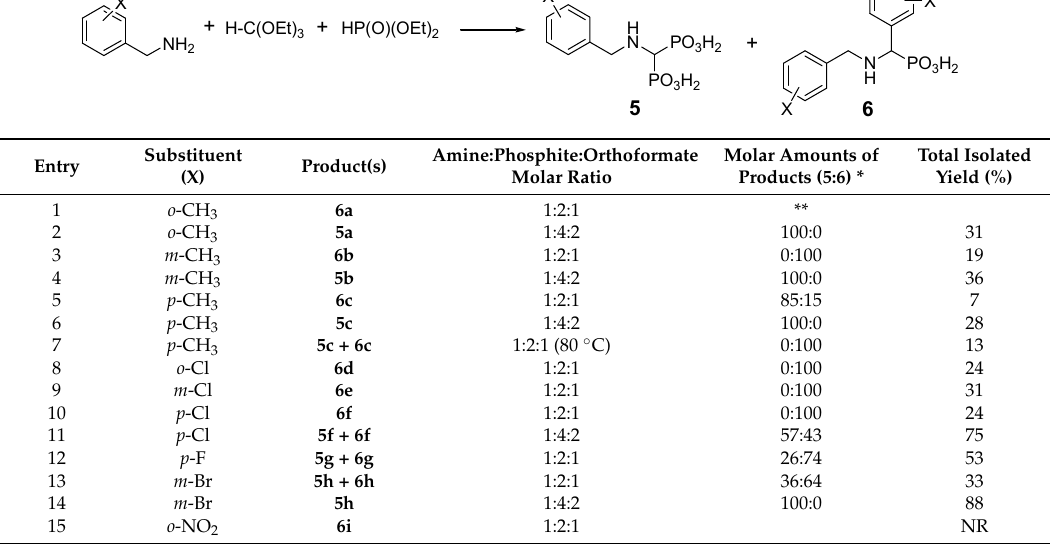
Table 2. Products of the reactions between substituted benzylamines, triethyl orthoformate and diethylphosphite.